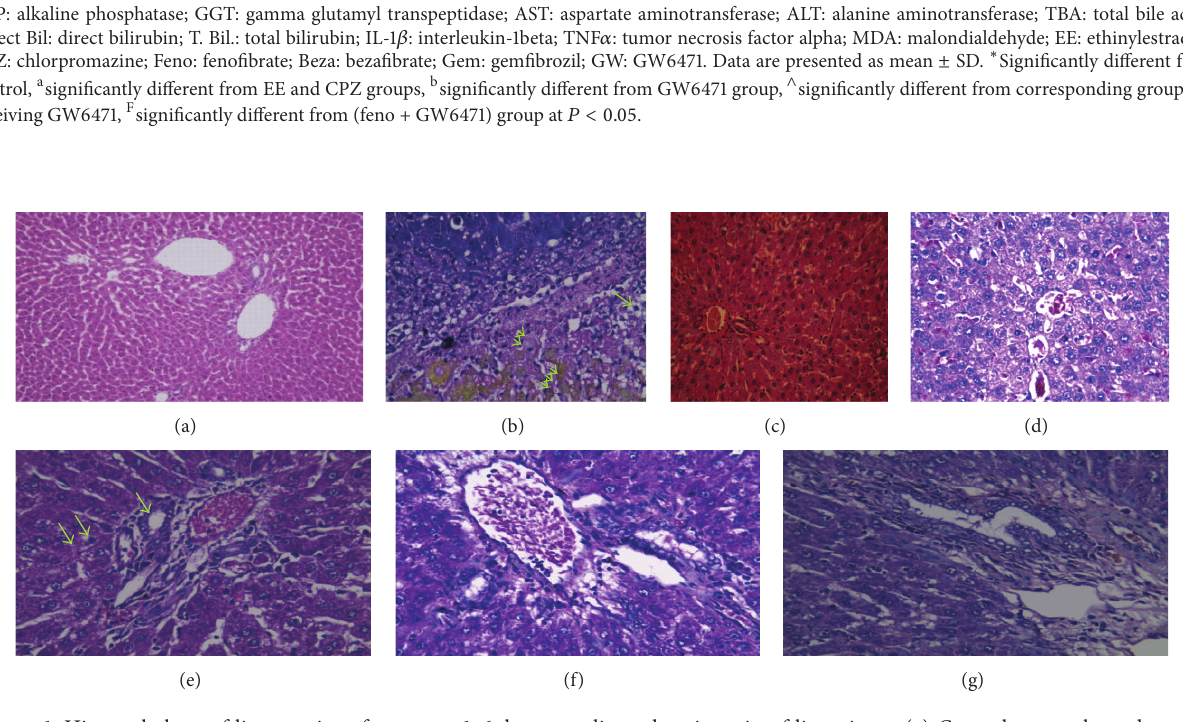
Figure 1: Histopathology of liver sections for groups 1–6: hematoxylin and eosin stain of liver tissue. (a) Control group showed normal hepatic architecture (H&E × 100). (b) Ethinylestradiol plus chlorpromazine treated group showed numerous apoptotic figures (pyknosis; one arrow and karyolysis; two arrows), intracellular bile pigments three arrows (H&E × 200). (c) Ethinylestradiol plus chlorpromazine treated group showed main bile duct obstruction, dilatation, and ductular proliferation (H&E × 100). (d) Ursodeoxycholic acid group showed ground glass cytoplasmic appearance of hepatocytes with congested dilated blood sinusoids (H&E × 200). (e) Fenofibrate group showed mild ground glass appearance of hepatocytes, proliferated bile ductules (one arrow) (H&E × 200). (f) Bezafibrate group showed proliferated bile ductules, congested central veins, and minimal mononuclear cellular infiltration (H&E × 200). (g) Gemfibrozil group showed mild hepatitic changes, portal tracts with mononuclear cellular infiltration, and proliferated bile ductules (H&E ×